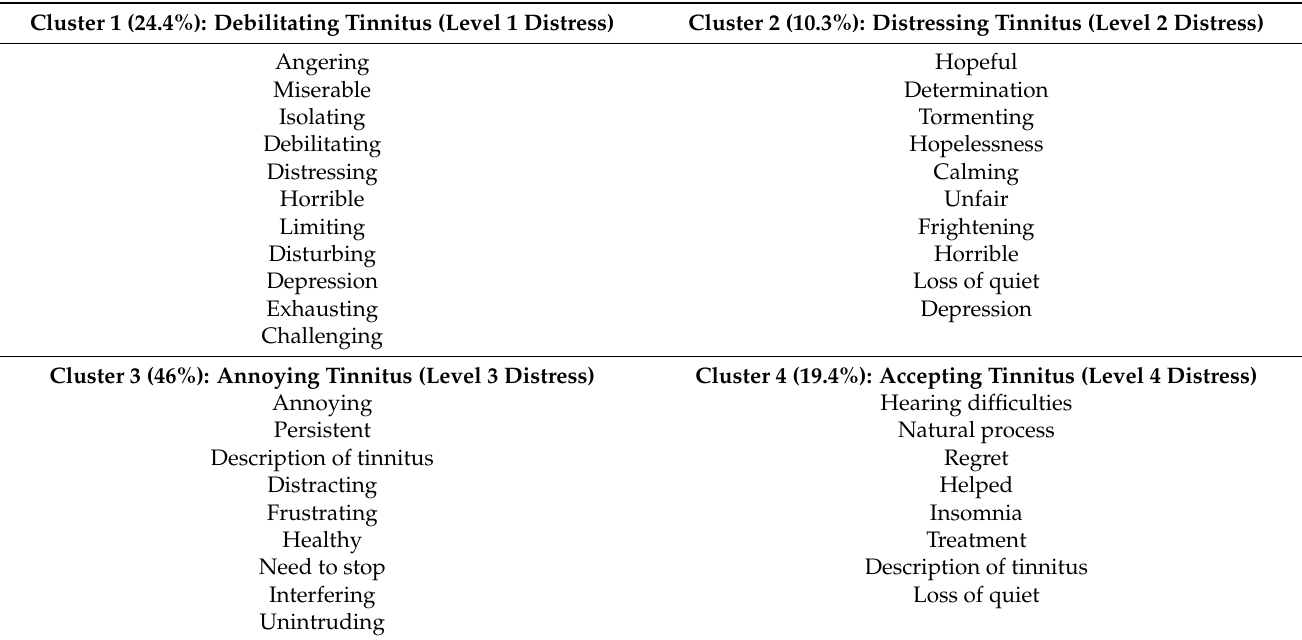
Table 3. Clusters based on responses to free association